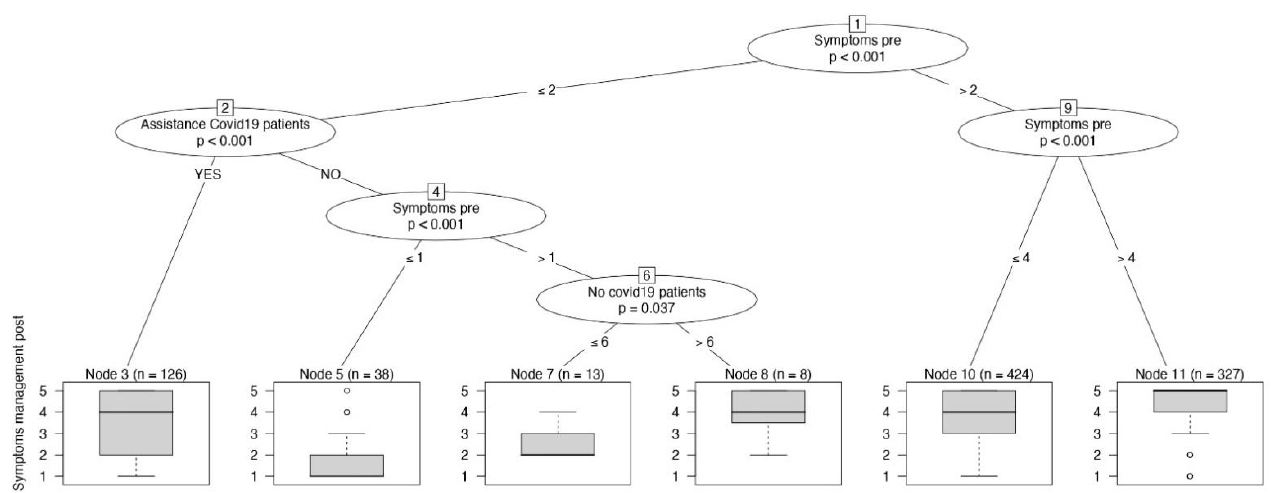
Figure 4. The conditional inference tree with the frequency of symptom management as dependent variable, reported at the bottom of the figure as boxplot.